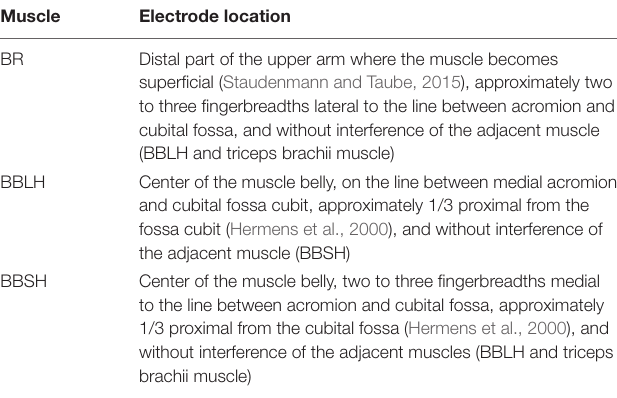
TABLE 1 | Electrode locations for each muscle. Muscle Electrode